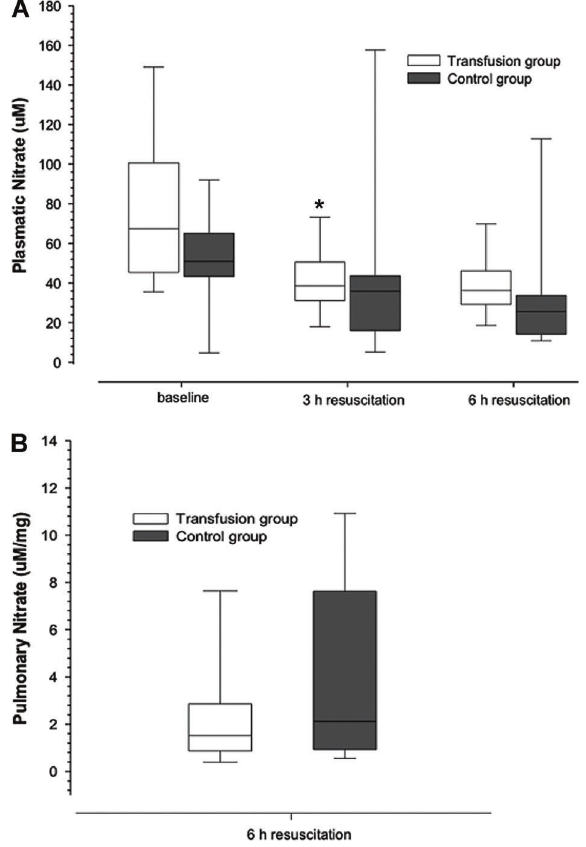
Figure 4. Nitrate concentrations of the groups during the study. Panel A , plasma nitrate concentrations of both groups (P=0.021, Friedman test). *P o 0.05 vs baseline (Tukey post-hoc analysis). Panel B , pulmonary nitrate concentrations of both groups (P=0.505, Mann-Whitney rank sum test). Data are reported as medians and interquartile range for 8 animals per group. Animals were sacri fi ced 6 h after the end of